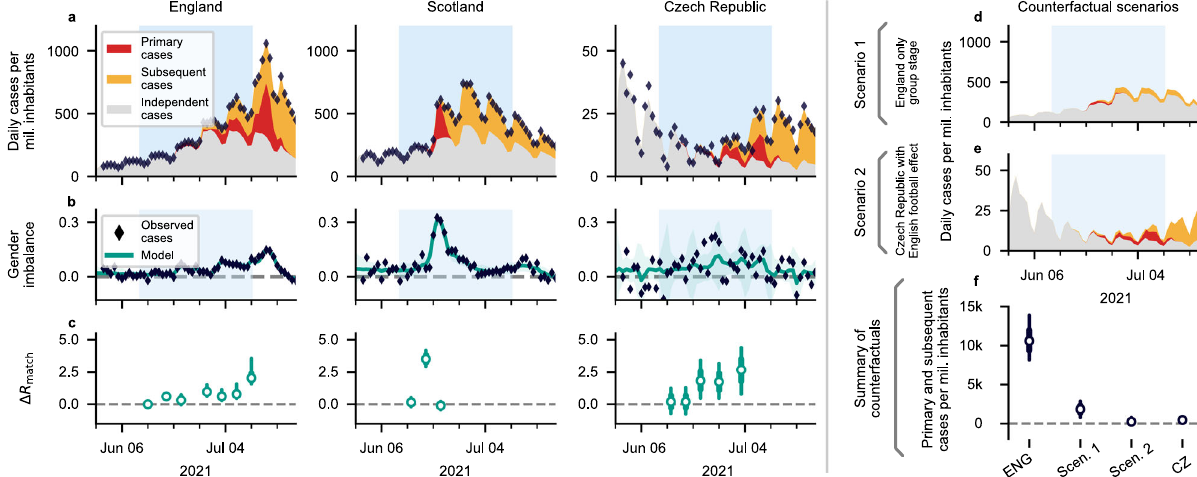
Δ R Δ R match concentrated on the day of each match. For example, match =2 means that, on the day of the match, each infected individual on average infected two additional persons (on top of the base trend). d , e The counterfactual scenario assumes that England would not have reached the knockout phase ( d , Scen. 1), or that the Czech fans and matches would have been equal to the English (i.e., reaching the fi nal,and Czechpeople doing the same football-related gatherings as the English by their impact on disease spread; e , Scen. 2). f In the counterfactual scenarios,theEuro2020would havehad muchsmallerimpactwithfewermatches (Scen. 1), or with an overall more favorable pandemic situation as in the Czech Republic (Scen. 2). White dots represent median values, bars and whiskers corre- spond to the 68% and 95% credible intervals (Fig.2).Forallcountries,wedisentangledthecasesthatareconsidered to happen independently of the Euro 2020 (Fig. 2a, gray), the primary (red),andthesubsequentinfectionchainsstartedbytheprimarycases